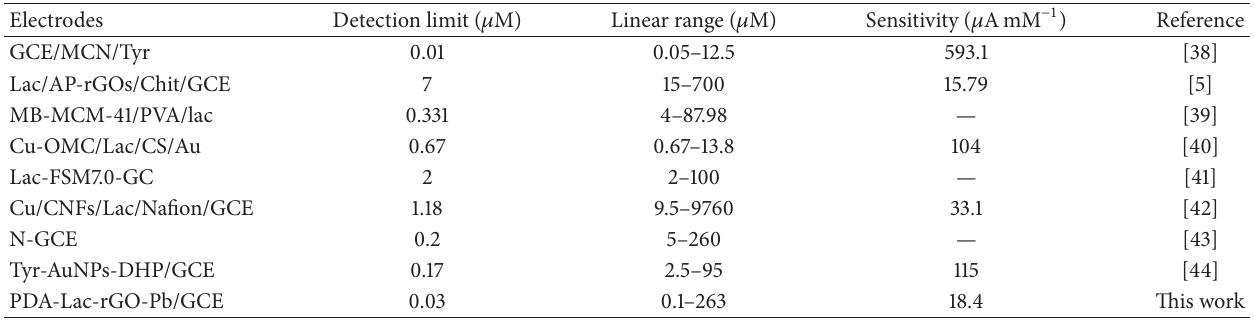
Table 1: Sensing performance comparison of different modified electrodes toward catechol a .